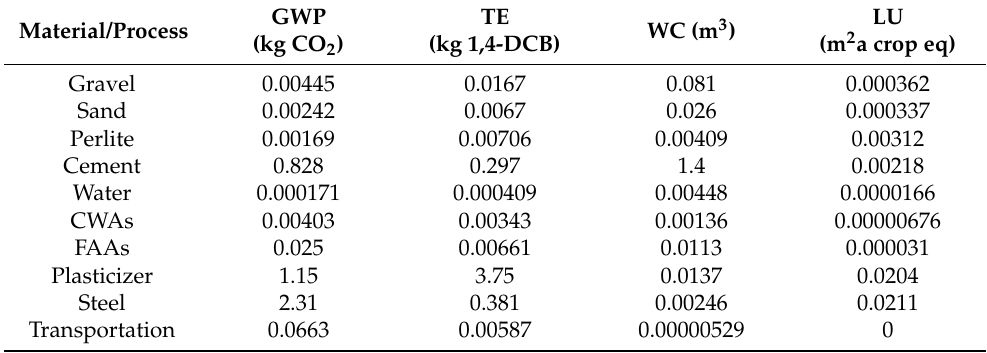
Table 9. Life-cycle inventory (LCI) for assessment of Cases 1–4 (Ecoinvent v3.2